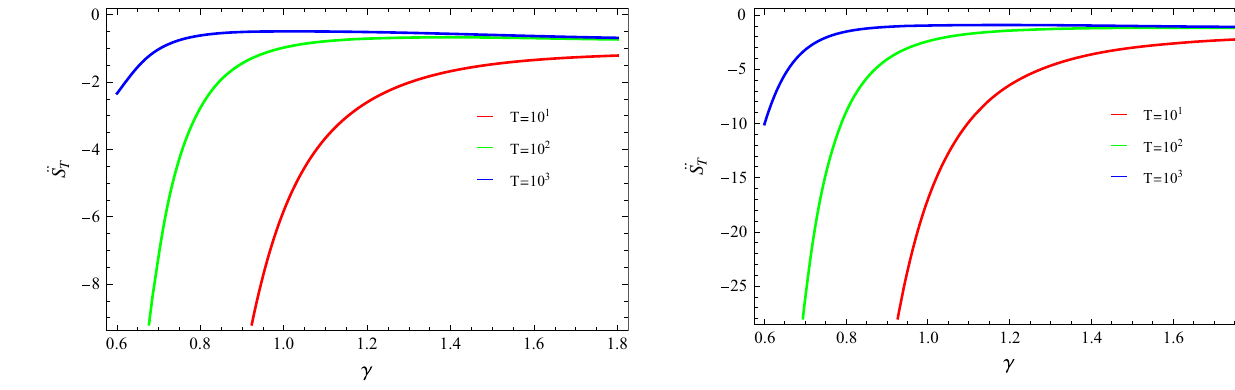
Fig. 6 Plot of ¨ S T versus γ when (cid:2) = (cid:2)( t )